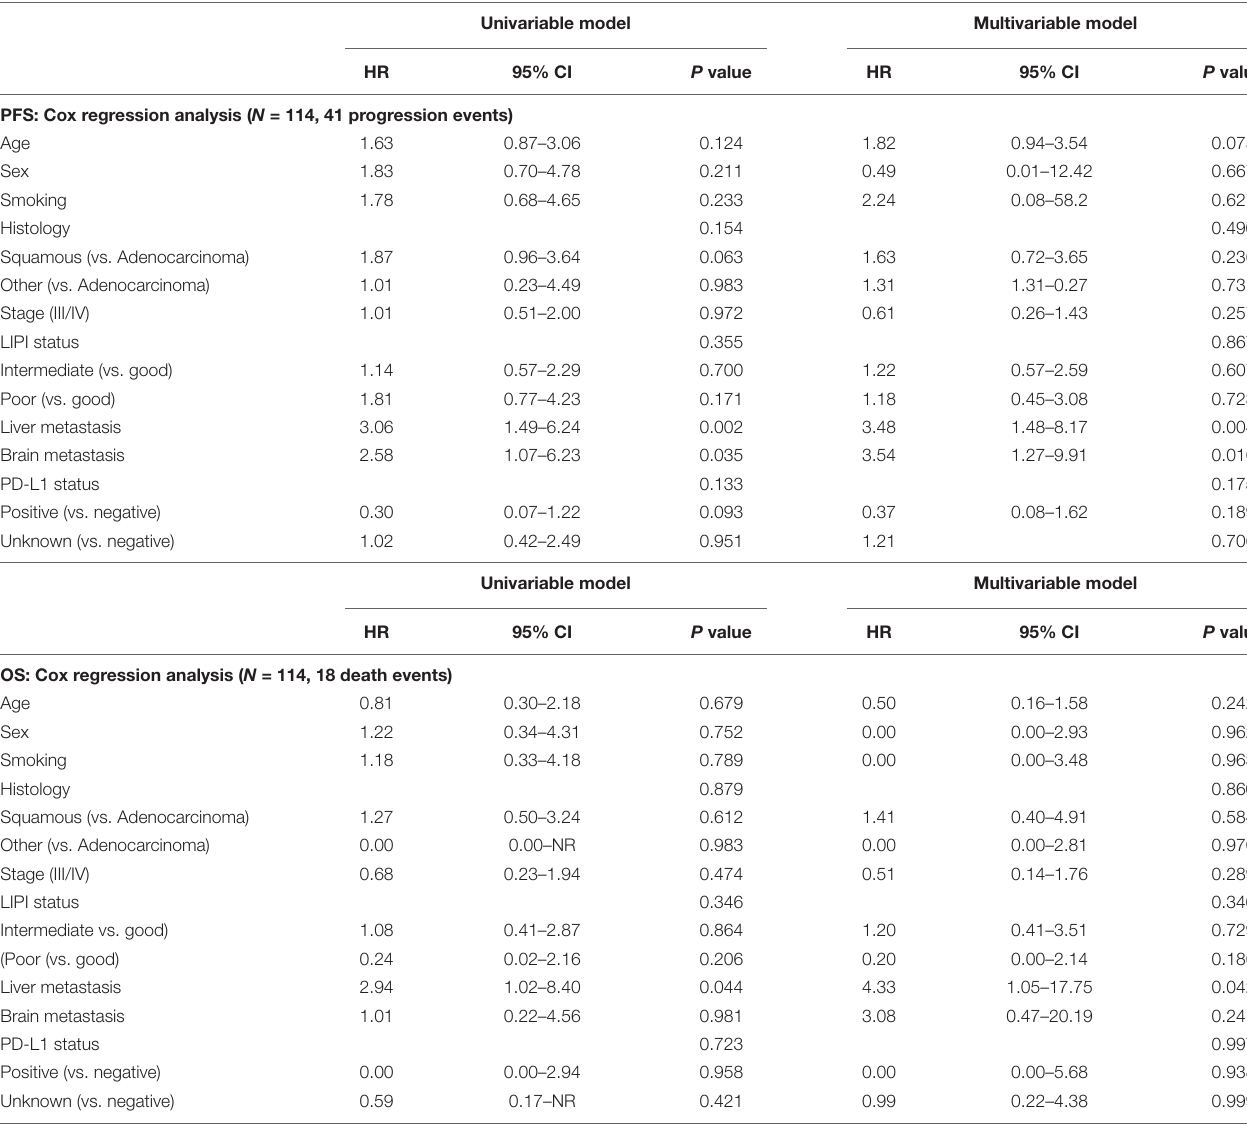
TABLE 3 | Univariable and multivariable analyses of progression-free survival (PFS) and overall survival (OS) in patients with ICIs combination chemotherapy. Univariable model Multivariable